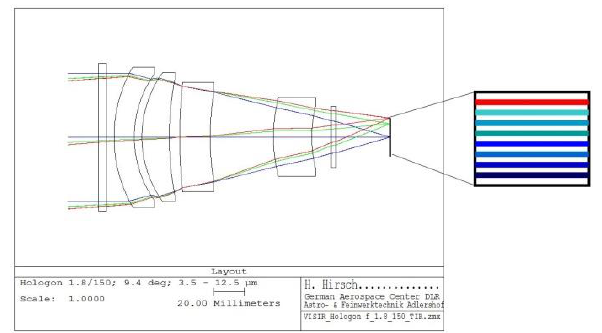
Figure 4. Design concept of the VISIR-SAT multi-spectral MIR/TIR sensor’s optics and focal plane with a Hologon optics for a wavelength region 3.5 – 12.5 µm and the schematically shown focal plane on the right hand site with a stripped filter arrangement (2 for MIR and 6 for TIR) - to be mounted on a cooled Mercury Cadmium Telluride (MCT) detector matrix